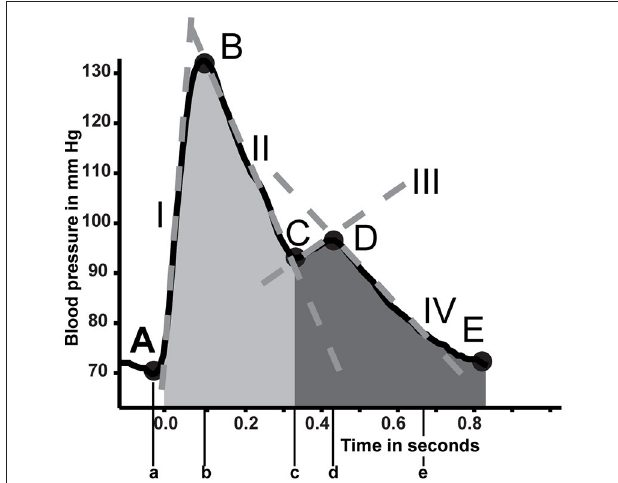
FIGURE 1 | In depth analysis of the blood pressure curve. Five primary points are detected (A to E). From these points several parameters are estimated (Table A1 in Supplementary material). Positions on the curve are indicated with capital letters A through E. Their accompanying time points are described with lower case letters. Tangent lines are described with roman numerals. Areas of interest are shaded.